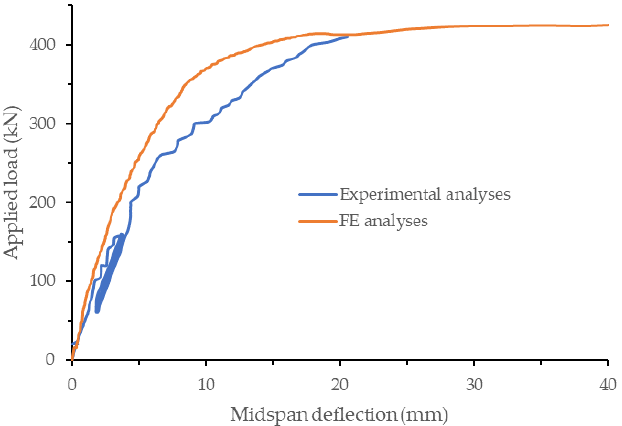
Figure 15. Load-displacement curve for a UHPC layer ratio of